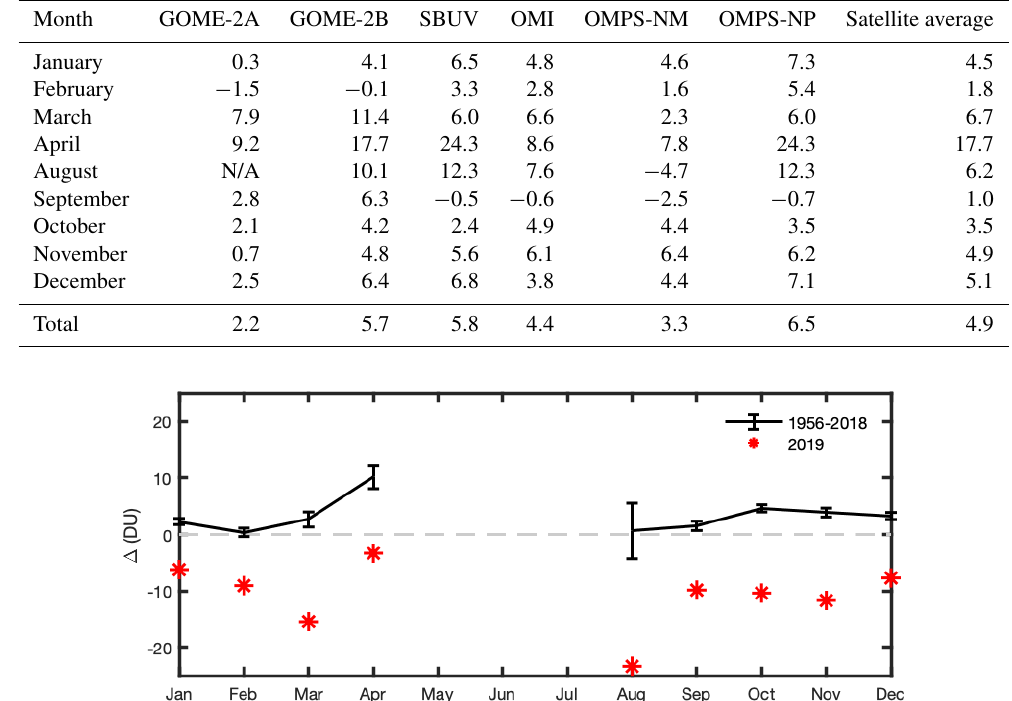
Figure 4. Average (cid:49) over all years (Fig. 2) excluding 2019 for each month with error bars (black). The monthly (cid:49) values with the automated Dobson in 2019 (red) have larger magnitudes than (cid:49) s in other years. The error bars represent the standard error of each satellite mean, combined in quadrature for each monthly